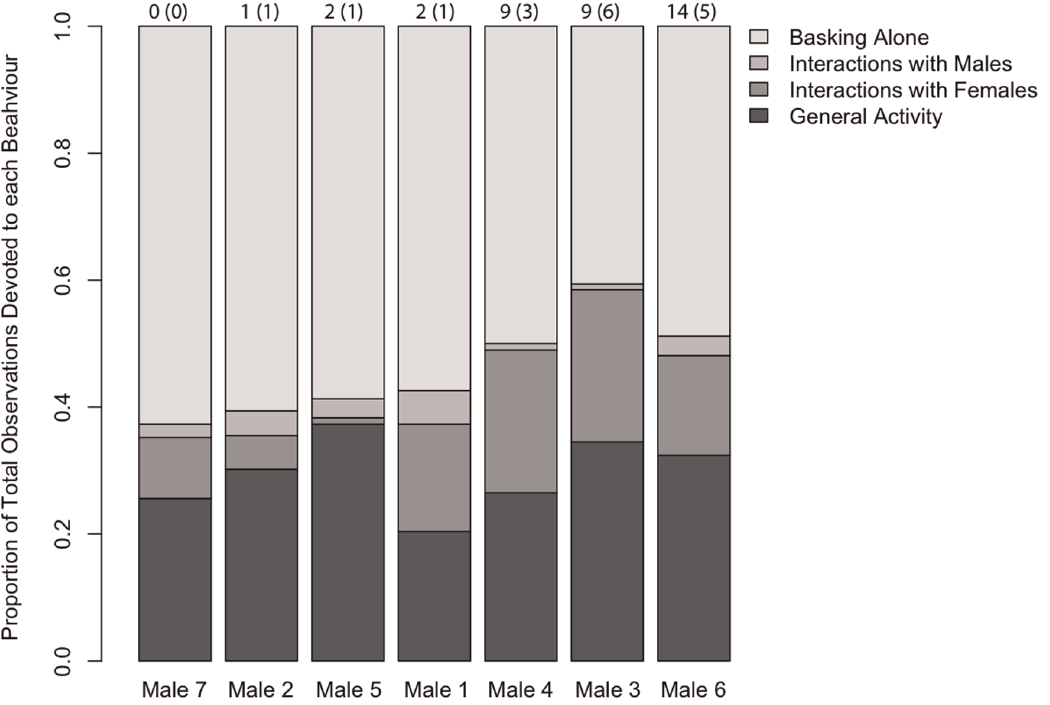
Figure 1. Summary of the proportion of activity for each behavioural category for each male. Total number of offspring sired by each male is shown above each bar with the number of clutches in parentheses.